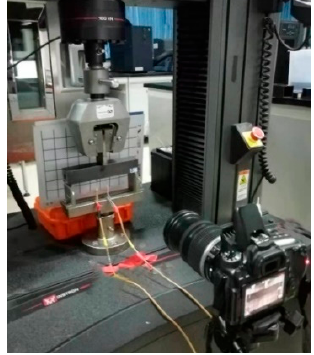
Figure 3. Schematic of the three-point bending experiment.